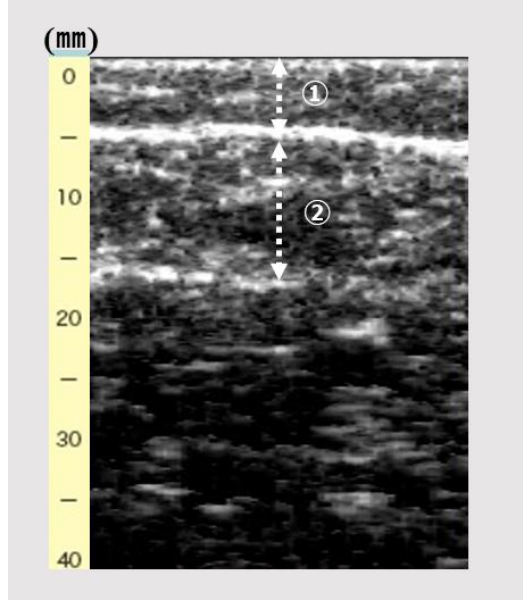
Figure 1. The image of subcutaneous fat and gastrocnemius thickness by ultrasonography. ➀ , Sub- cutaneous fat thickness (mm); ② , gastrocnemius thickness (mm).